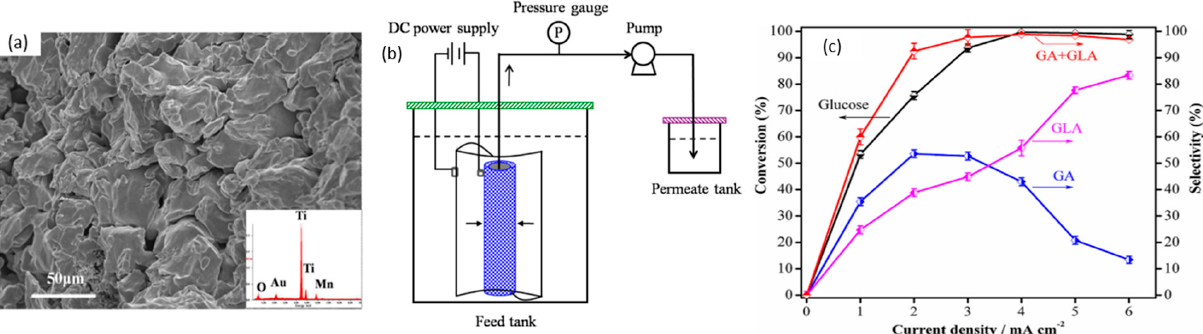
Figure 8. Nano MnO 2 /Ti electrocatalysts in flow-through cells for glucaric acid (GA) and gluconic acid (GLA) production from glucose. ( a ) SEM image of 5% MnO 2 /Ti electrode. ( b ) Schematic diagram of electrocatalytic flow reactor system. ( c ) Products at different current densities (under 5% MnO 2 loading, glucose concentration of 50.5 mmol/L, pH of 7, 30 °C, 19 min). Reprinted with permission from Ref [54]. Copyright 2014, Electrochimica Acta.